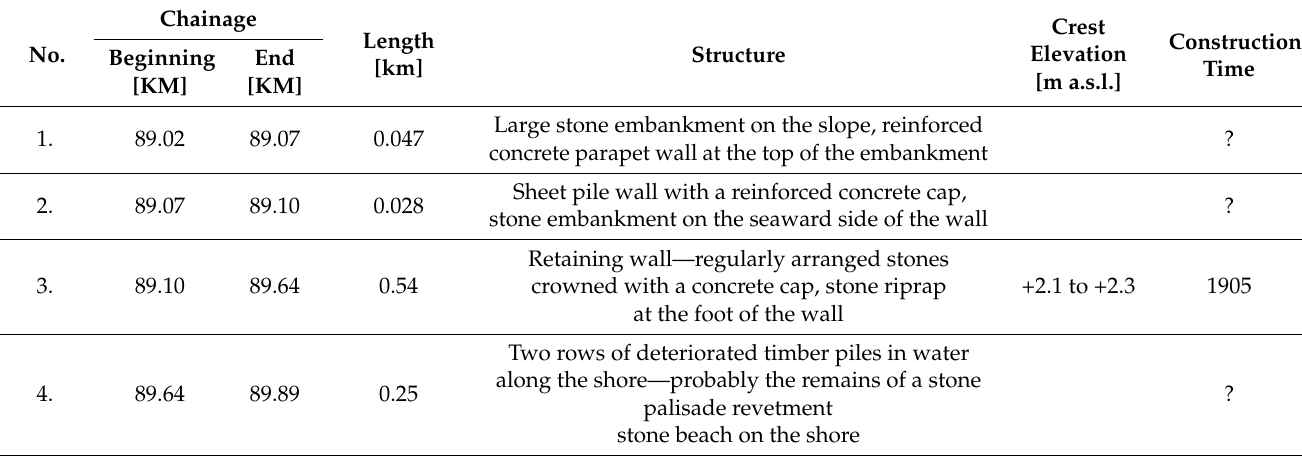
Figure 10. Torpedo station put into service in 1942. The blue arrow indicates the approximate location of KM 93.6–93.9. Table 1. Revetments in the area of